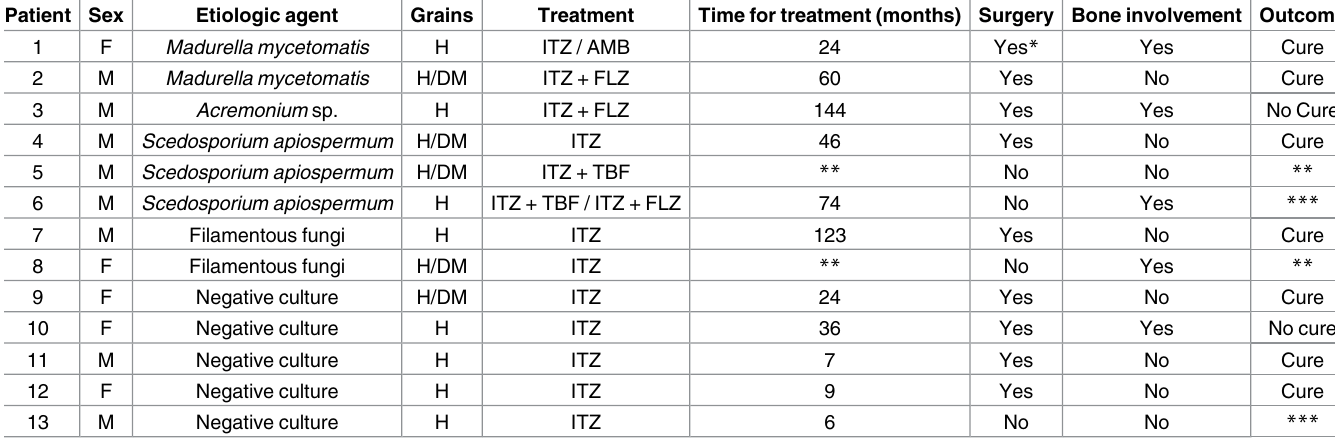
Table 2. Main characteristics of 13 patients with Eumycetoma.